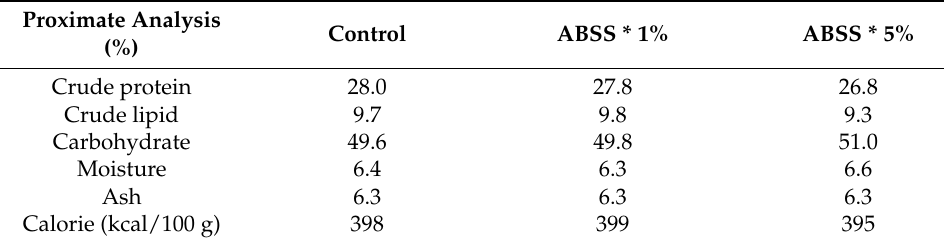
Figure 6. Agaricus blazei spent substrate extract (ABSSE) inhibits the growth of Streptococcus agalactiae . ( A ) The left and right wells of tryptone soy agar (TSA) that spread with Streptococcus agalactiae were inoculated with 100 μL of ABSSE (left, 50 mg/mL) or water extract of unfermented growth substrate (right, control) followed by a 24 h incubation at 28 °C. ( B ) Here, 100 μL of Streptococcus agalactiae (10 6 C.F.U./mL) in tryptone soy broth (TSB) was mixed with 900 μL of TSB with or without 50 mg/mL of ABSSE followed by a 2 h incubation at 28 °C. Then, 100 μL of mixture was spread on TSA and incubated 16 h at 28 °C. Colony counts from triplicate plates were recorded and data are shown as the means ± standard errors of the mean. Significant differences from the control group are denoted by asterisks ( p < 0.05, paired-sample t -test). C.F.U. = colony forming unit. Table 4. Proximate composition of the experimental diets.